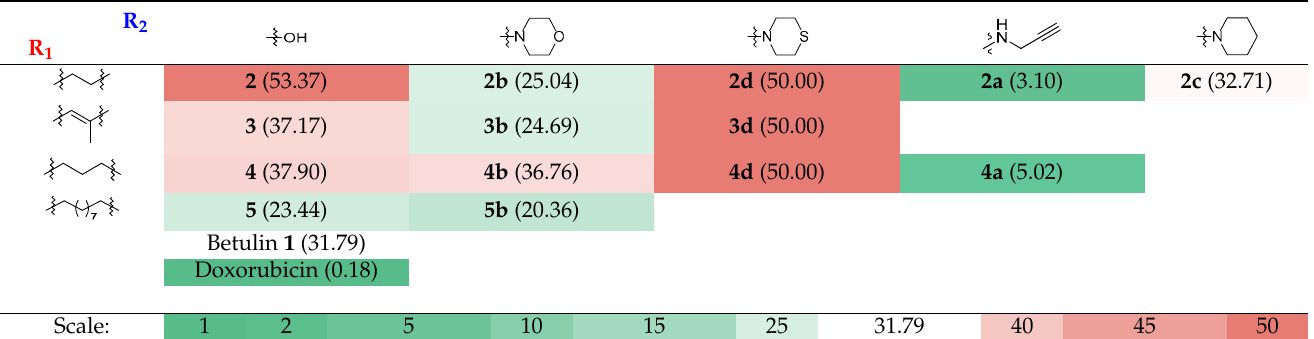
The color scheme visualizes active compounds in green and inactive ones in red. Color saturation corresponds to their degree of activity as indicated on the scale.